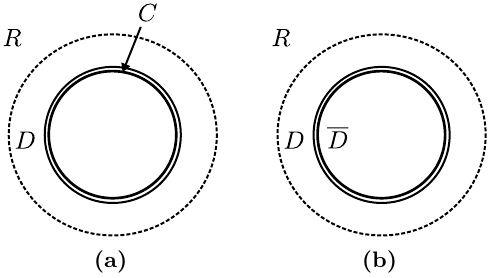
Figure 2 . The Hilbert space structures. The dotted line represents r = 3 GM and the double lines represent r = 2 GM (cid:15) . Roughly, D corresponds to the zone. (a) The outside Hilbert space (cid:6) . (b) The infalling Hilbert space H outside H inside